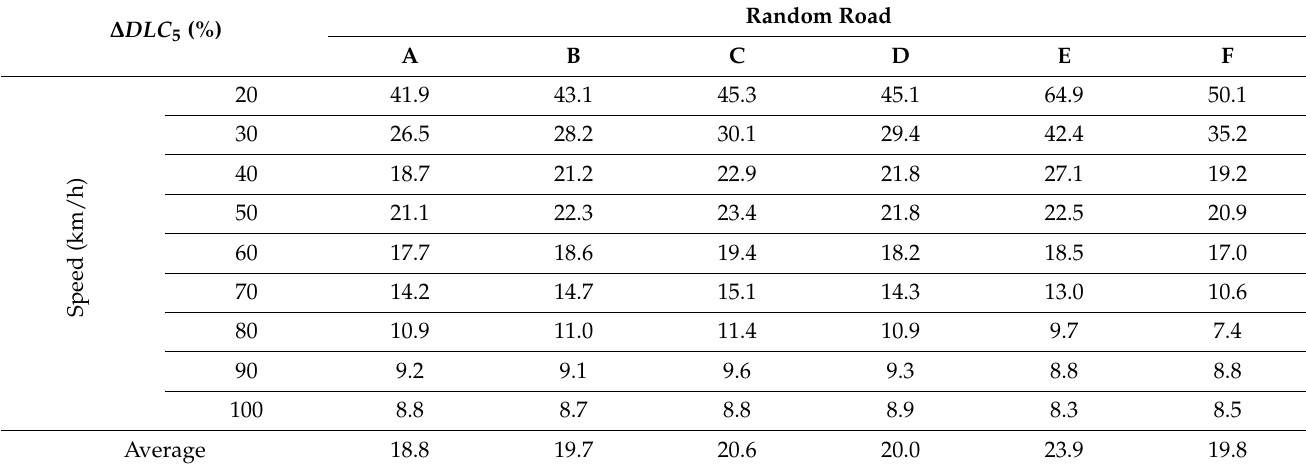
Table 5. The extent of the reduction of ∆ DLC (%): 5th